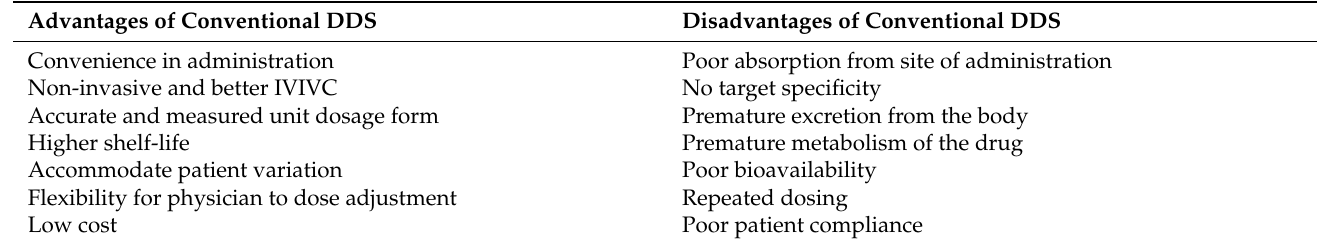
Table 3. Advantages and disadvantages of conventional delivery systems.